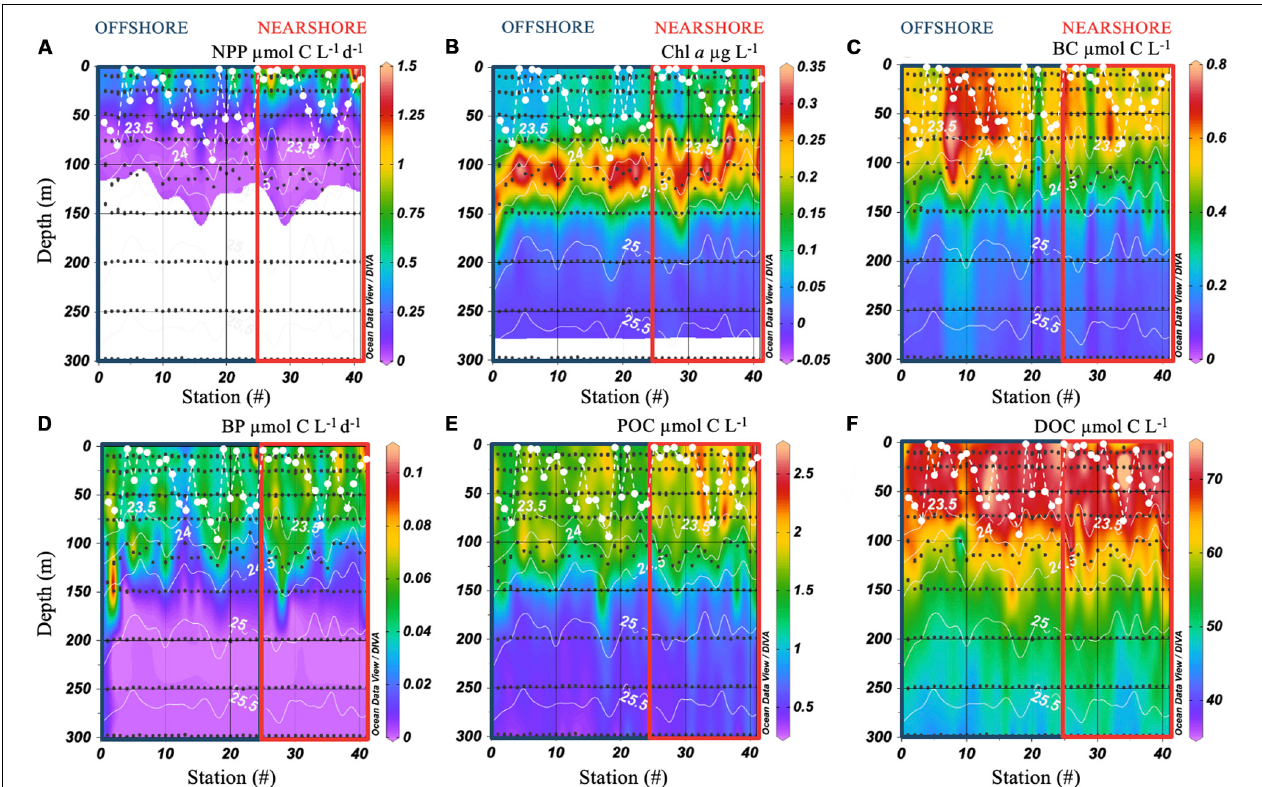
FIGURE 2 | Contour plots of net primary productivity (NPP; A ), chlorophyll a (Chl; B ), bacterioplankton carbon (BC; C ), heterotrophic bacterioplankton productivity (BP; D ), particulate organic carbon (POC; E ), and dissolved organic carbon (DOC; F ) in the upper 300 m of the water column. Black dots indicate sites of seawater collection. The dashed white line represents mixed layer depth at each station. Solid white contour lines are potential density anomaly (kg m − 3 ). Color boxes indicate offshore (blue) and nearshore (red) stations as in Figure 1 .